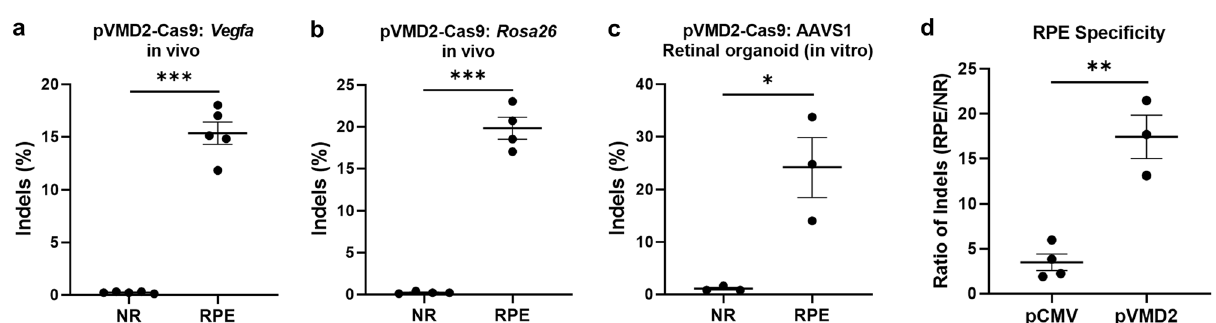
Figure 4. RPE-specific gene editing by pVMD2-SpCas9. ( a , b ) Subretinal injection of two lentiviruses containing pVMD2-SpCas9 and mouse Vegfa- or Rosa26 -targeting guide RNA (gRNA) was performed. Generated indels (Insertion and deletion) efficiencies were significantly higher in RPE than in neural retina (NR) ( Vegfa , p = 0.005; Rosa26 , p < 0.001); ( c ) When lentiviruses of pVMD2-SpCas9 and human AAVS1 - targeting gRNA were transduced into human retinal organoid containing RPE sphere, indel efficiencies were significantly higher in RPE than in NR ( p = 0.016); ( d ) The ratio of indels generated in RPE compared to indels generated in the neural retina (NR) was defined as RPE specificity. pVMD2-SpCas9 showed significantly higher RPE specificity than pCMV-SpCas9 ( p = Vegfa -gRNA, p = 0.002]. There was no difference between the pCMV-SpCas9 and pVMD2-SpCas9 groups ( p = 0.538) (Fig. 5c).